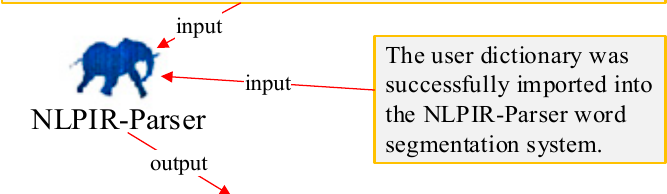
Figure 3. Text segmentation using the user dictionary.